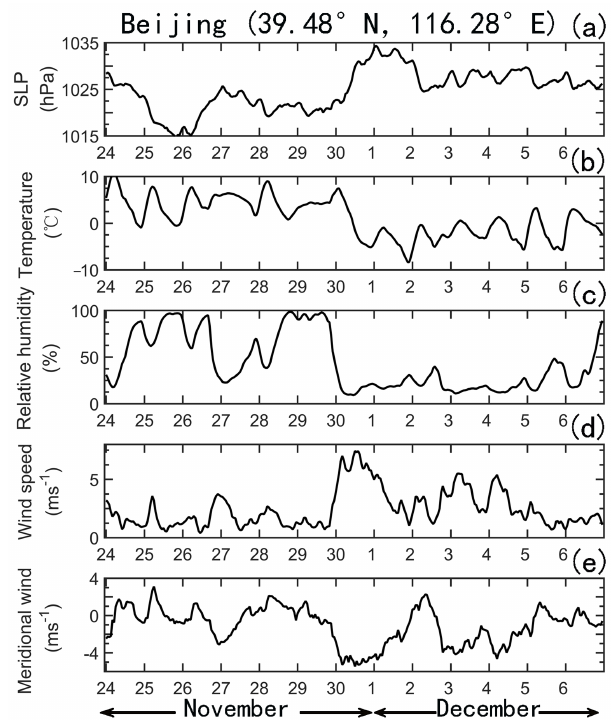
Figure 3. Time series of surface ( ∼ 1 . 2m above the surface) hourly meteorological measurements of (a) sea level pressure, (b) temper- ature, (c) relative humidity, (d) horizontal wind, and (e) meridional wind during the period 24 November–6 December 2014, observed over the Beijing station (39.4 ◦ N, 116.2 ◦ E; 31.3ma.s.l.).